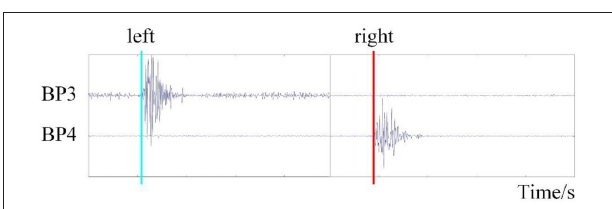
FIGURE 3 | The time of movement onset detection based on EMG. FIGURE 4 | The selected EEG datasets for the RP